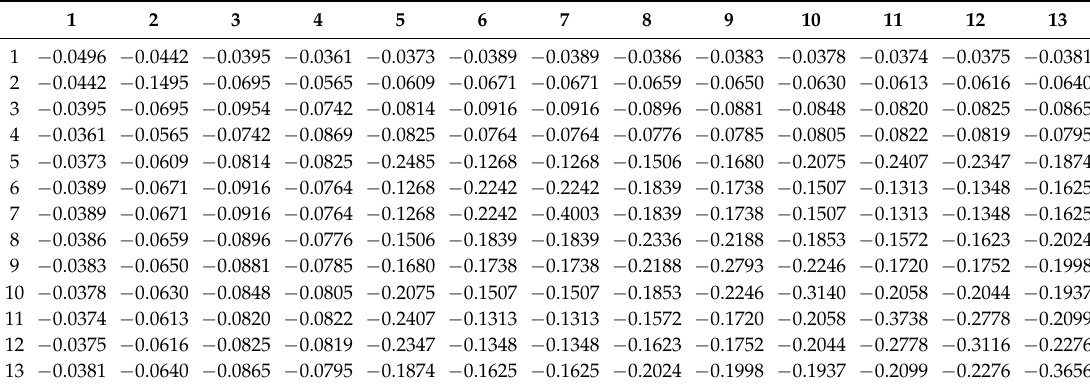
Table 2. Matrix B v in a 14 buses system.